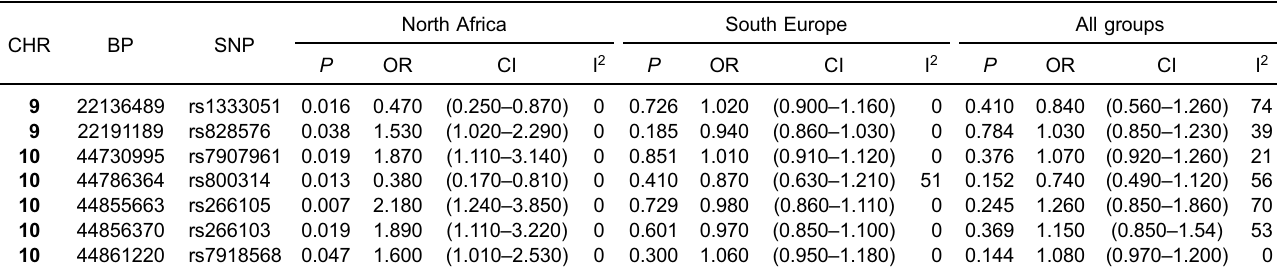
Table 2. Results of the three meta-analyses performed in North Africans, South Europeans, and merging both continental groups North Africa South Europe All CHR BP SNP